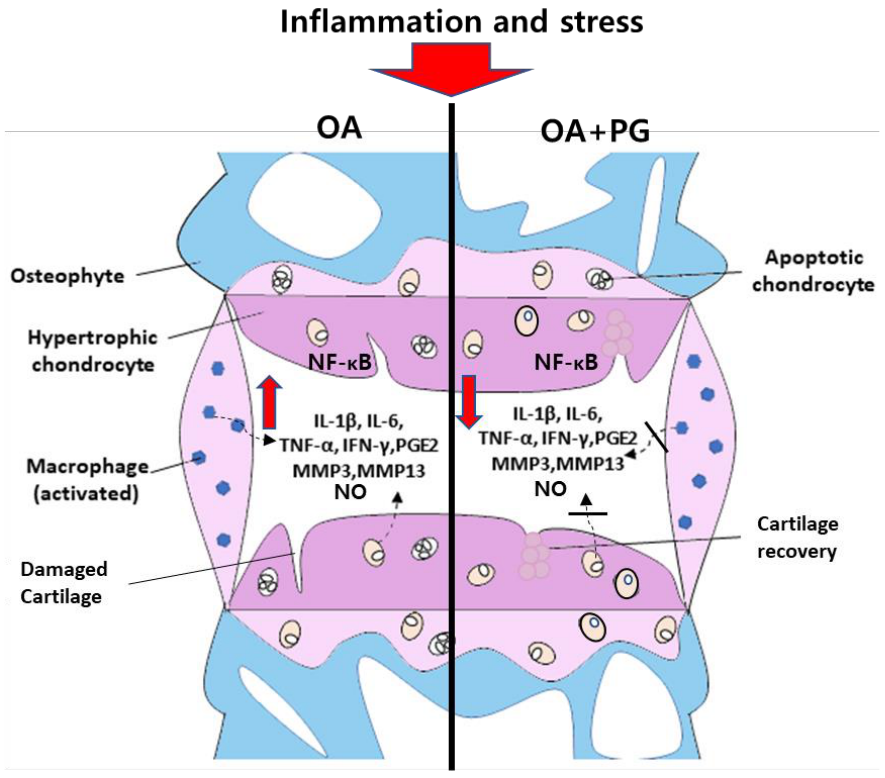
Figure 8. Molecular mechanism for the inhibition of inflammatory cytokines using a PG extract.